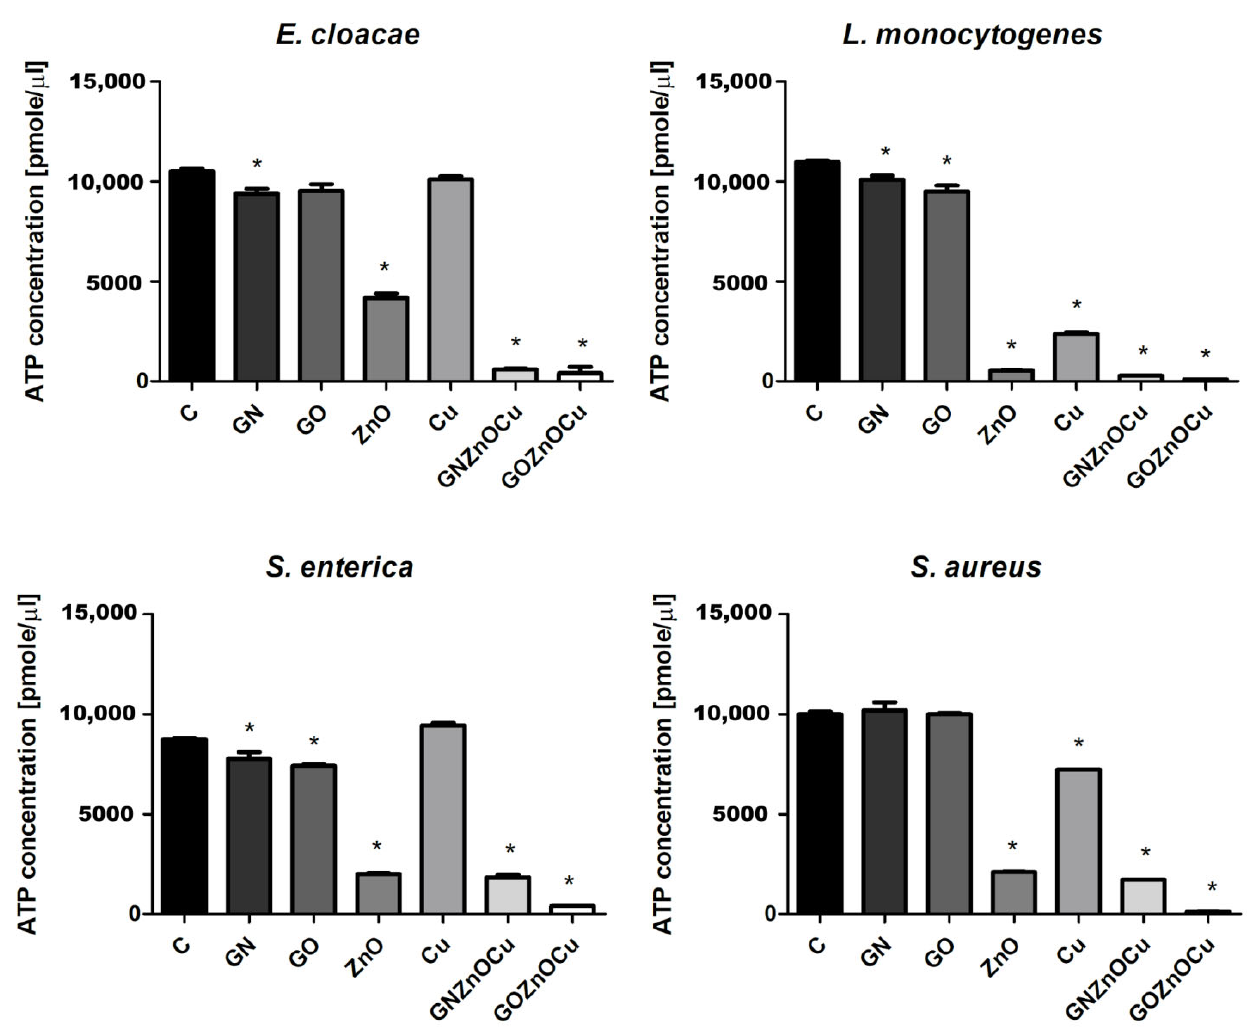
Figure 8. ATP content in bacteria species after treatment with nanomaterials. C signifies the control samples, and the results are mean values ± standard deviation. “*” symbols indicate statistically significant differences in comparison to the control.